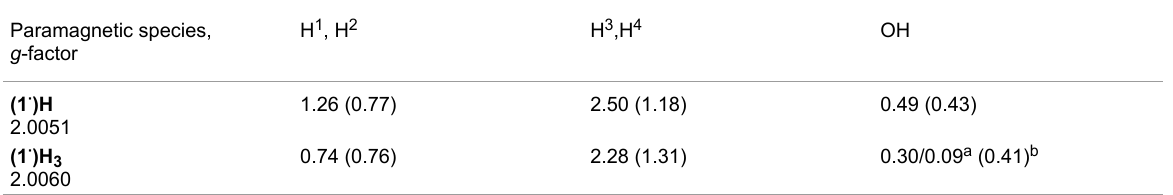
Table 1: Hyperfine splitting constants and g -factors of protonated semiquinones. The values in brackets correspond to the analogous lithium deriva- tives. Paramagnetic species, g